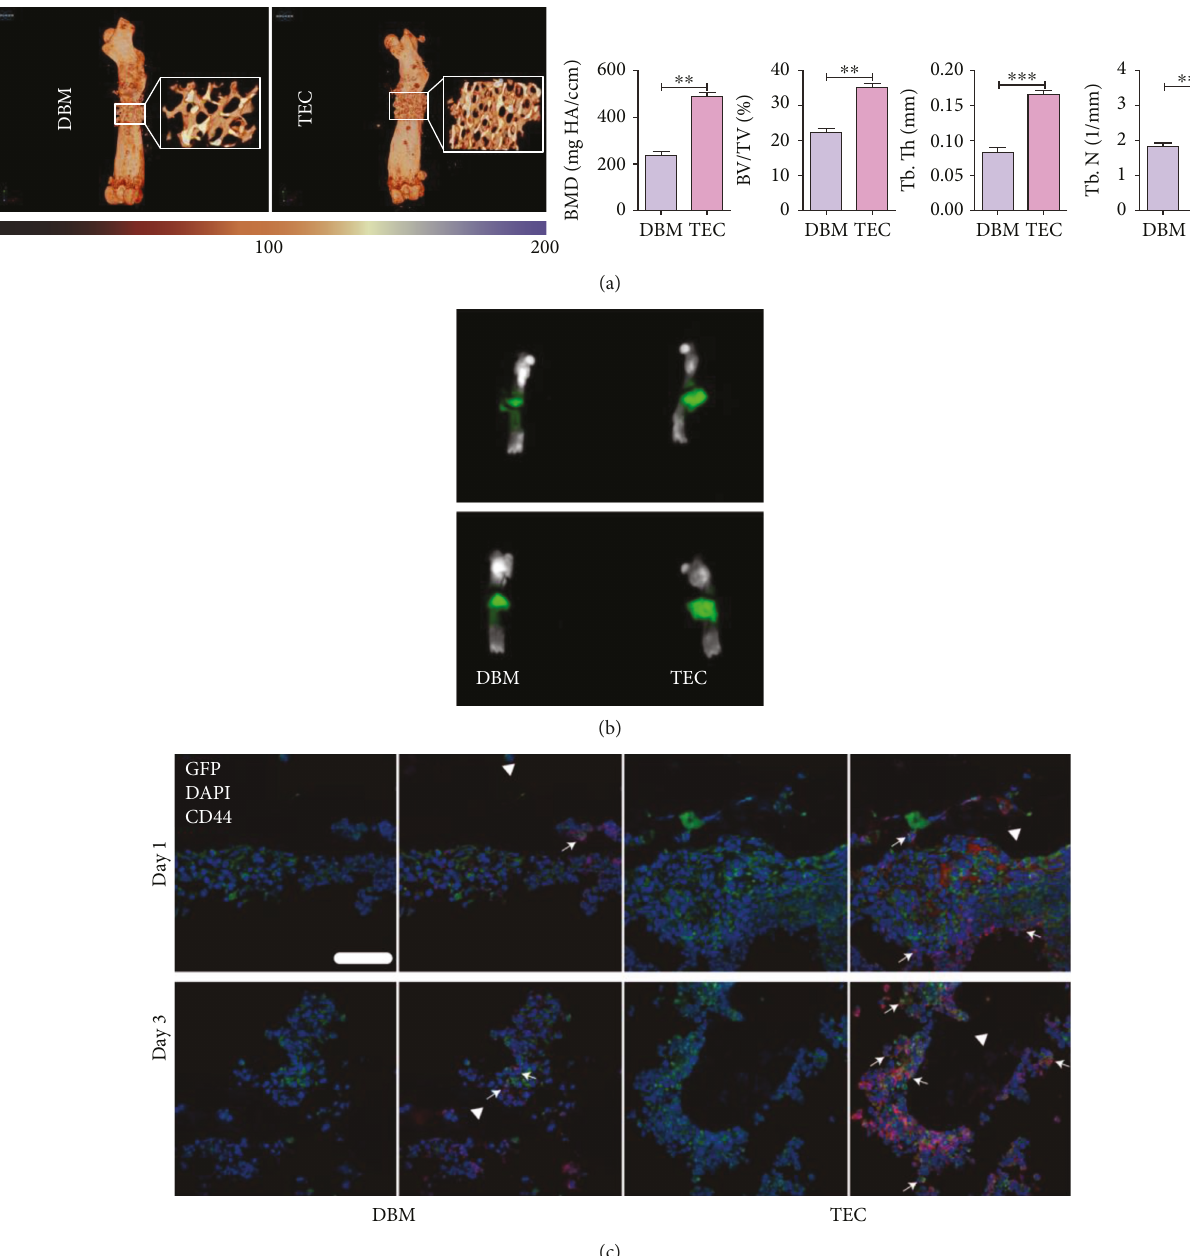
Figure 3: Imaging examination and in vivo recruitment of BM cells towards di ff erent implants. (a) A more calci fi ed bone matrix was observed in the TEC group compared to that in the DBM group by micro-CT. The osteogenic parameters of TECs were all signi fi cantly better than DBM. (b) Representative images from IVIS. The implantation sites of TECs showed higher fl uorescence intensity than DBM (days 1 and 3). (c) Representative images of in vivo migration of GFP + /CD44 + cells revealed by immuno fl uorescence staining. Postoperatively, more GFP + and GFP + /CD44 + cells emerged in TECs than in DBM. TECs, tissue-engineered constructs; white triangle, implant area; white arrows, GFP + /CD44 + cells; scale bar, 50 mm. ∗∗ P < 0 01